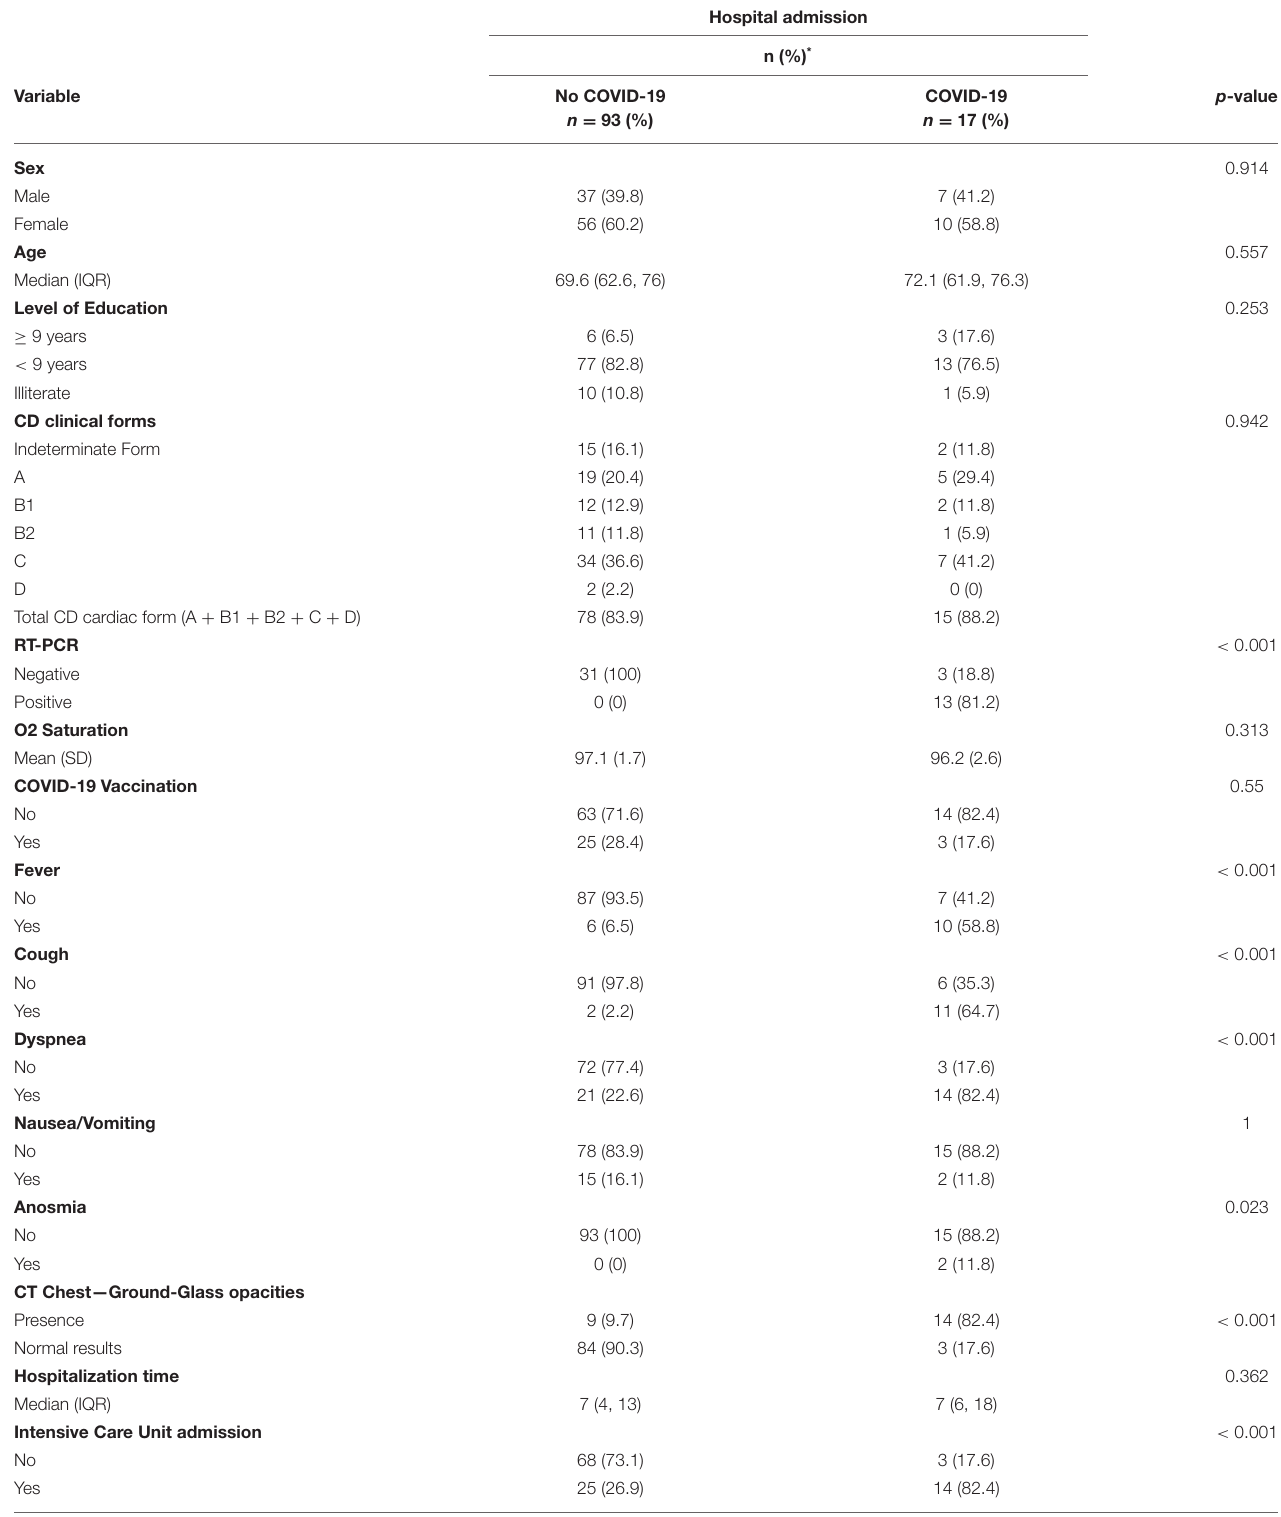
TABLE 2 | Comparison of demographic and clinical characteristics between hospital admissions due to COVID-19 and other causes ( n =